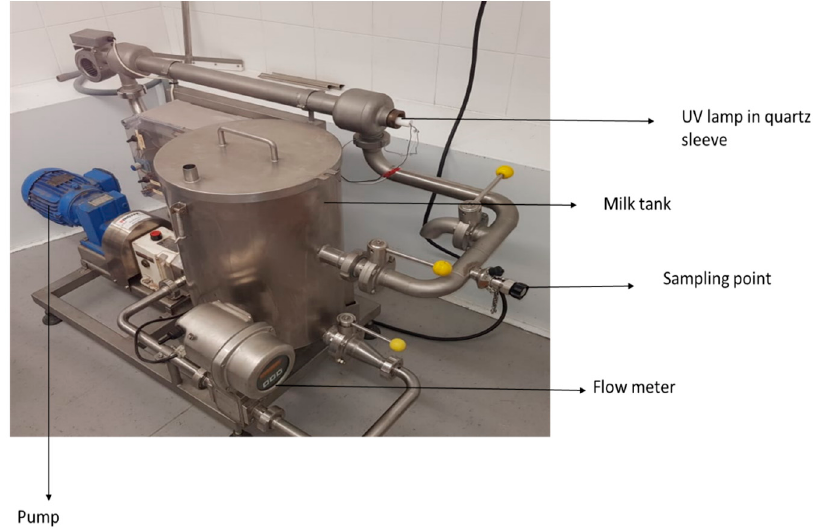
Figure 1. SurePure SP1 UV system. Table 1. Bacterial growth